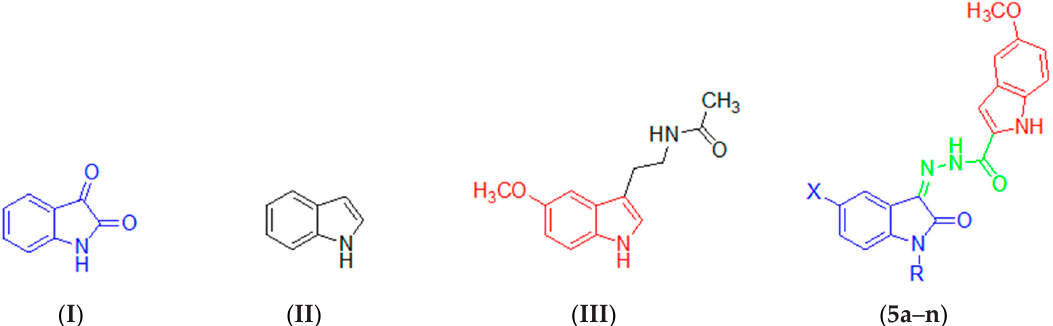
Figure 1. Chemical structures of isatin ( I ), indole ( II ), melatonin ( III ), and the target compounds 5a – n .